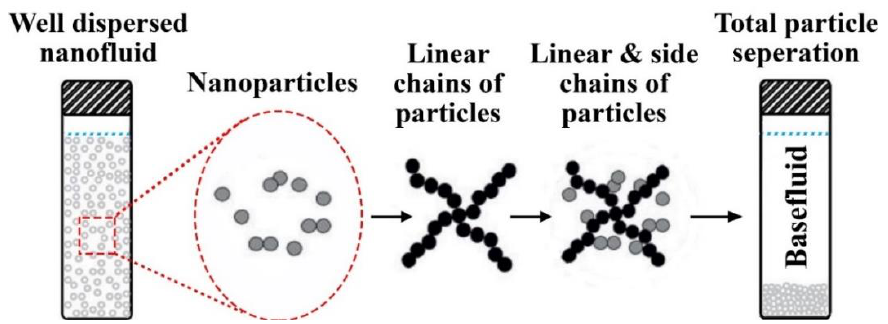
Figure 16. Nanoparticles separation due to the formation of both linear and side chains in the base